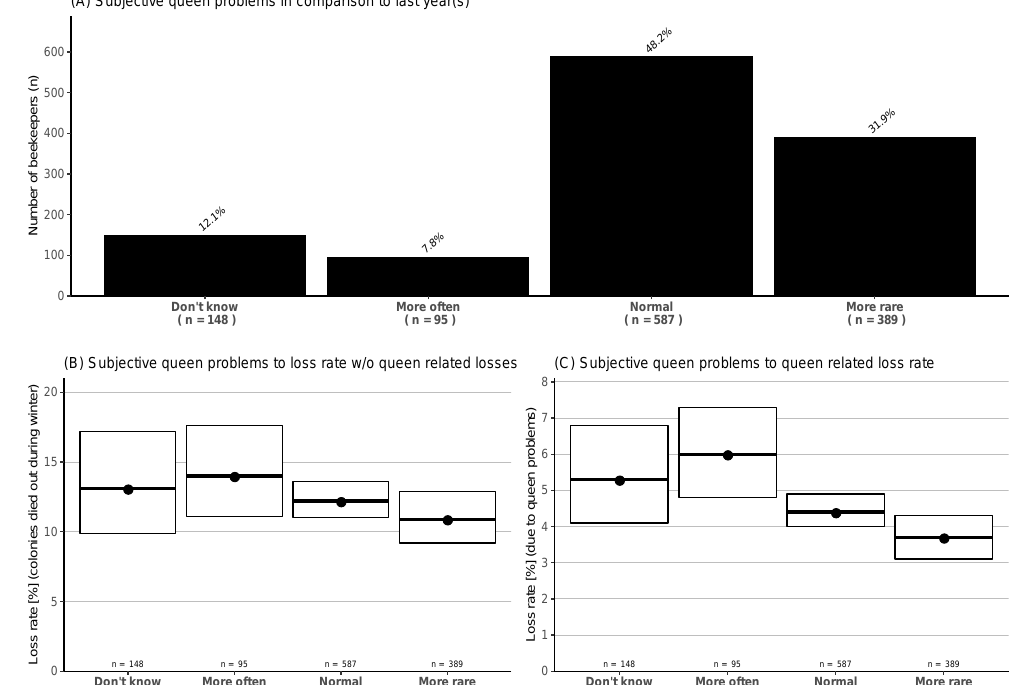
Figure 5. ( A ) Rating of observed queen problems during the foraging season in four categories compared to previous season(s). ( B ) Winter honey bee colony loss rates (and 95% CI) without queen-related losses to queen problem occurrences. ( C ) Queen-related loss rate (and 95% CI) related to queen problem